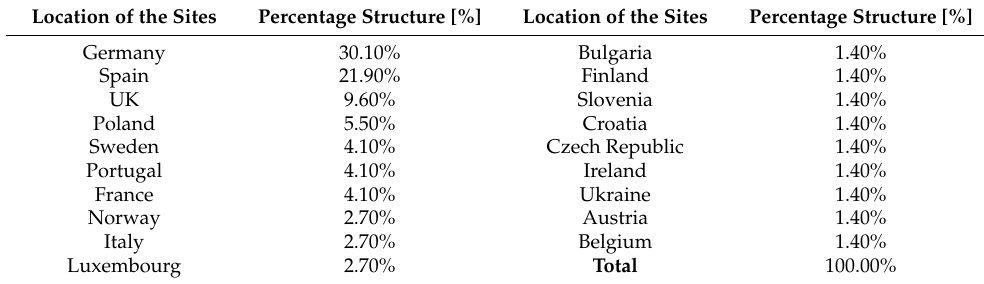
Table 1. Location of the sites taking part in the research, along with their actual participation. Location of the